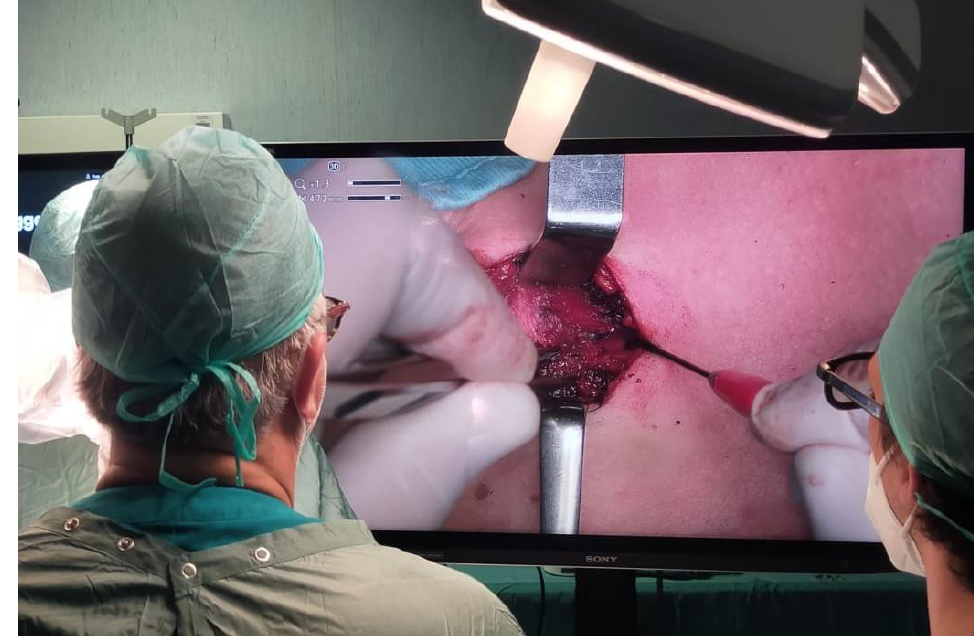
Figure 2. Intraoperative view of surgical field.